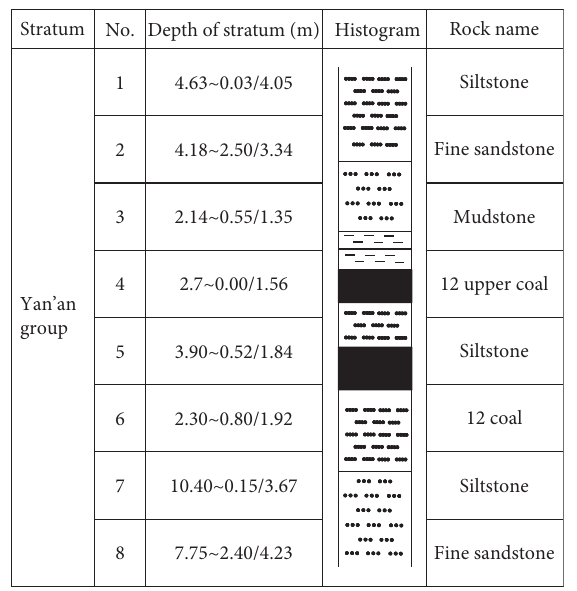
Figure 4: Comprehensive histogram of 12201 fully mechanized mining face.